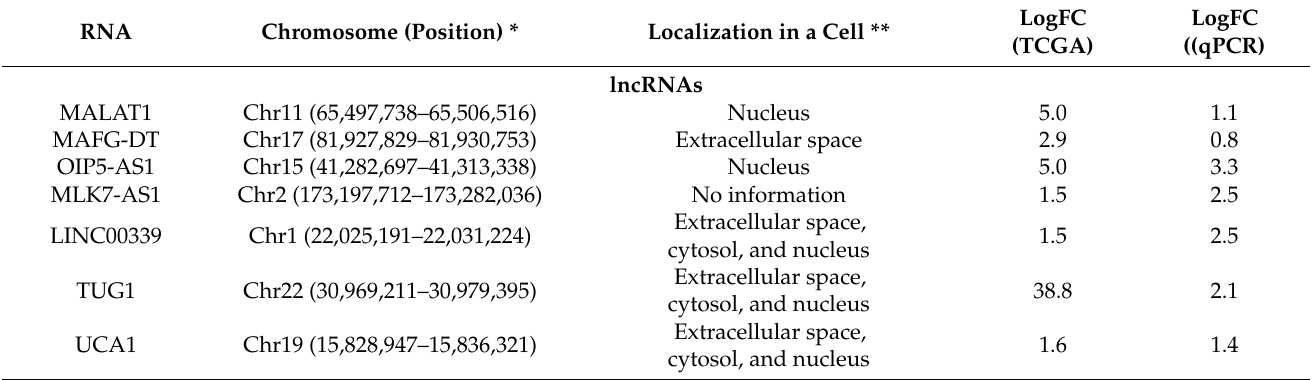
Table 1. Characteristics of the selected RNAs.